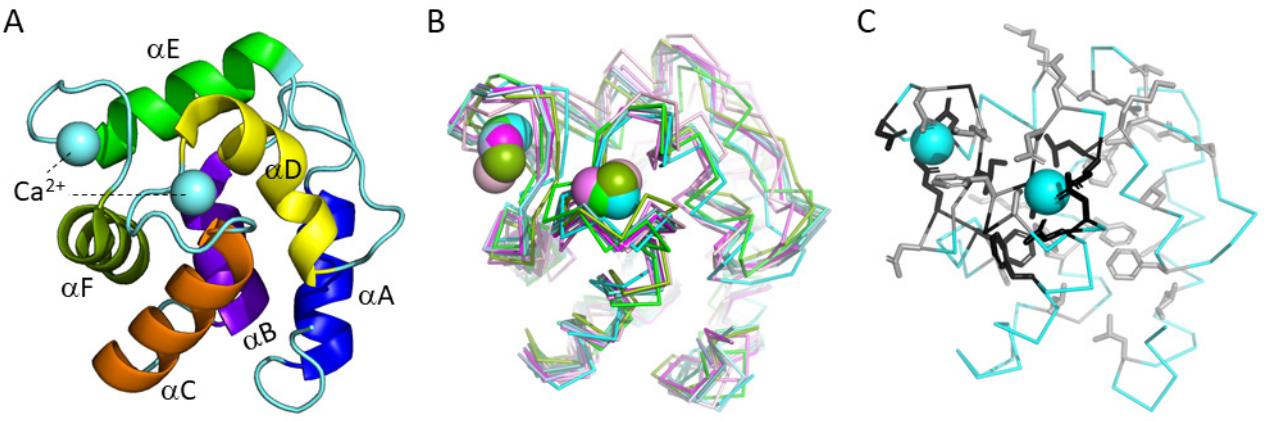
Figure 1. Parvalbumins have six α -helices A-to-F and two “EF-hand” domains for binding Ca 2+ ions (indicated as spheres). ( A ) The structure, in cartoon format, of common carp pvalb4_(Chr.A3) (PDB accession 4CPV) [10], which was the first parvalbumin of which the structure was elucidated [11]. Different α -helices are in different colors. ( B ) Superimposition of various parvalbumin structures, in ribbon format, reveals a common structure. Light pink, human α -parvalbumin (1RK9); pink, pike pvalb7 (2PAS); magenta, spotless smooth-hound shark SPV-I α -parvalbumin (5ZGM); green, human oncomodulin (1TTX); splitpea green, chicken CPV3-oncomodulin (2KYF); soft purple, chicken ATH (3FS7); cyan, Atlantic cod pvalb2 (2MBX); green cyan, pike pvalb3 (1PVB); aquamarine, common carp pvalb4_(Chr.A3) (4CPV); light teal, spotless smooth-hound shark SPV-II (5ZH6). ( C ) Most of the conserved EF-hand family residues belong to the Ca 2+ binding regions (see also Figure 5). The structure, in ribbon format, of common carp pvalb4_(Chr.A3) (PDB accession 4CPV), shows in black those residues that are well conserved throughout EF-hand domain family molecules and in gray other residues that are well conserved throughout parvalbumins; the sidechains of these residues are shown in sticks format.